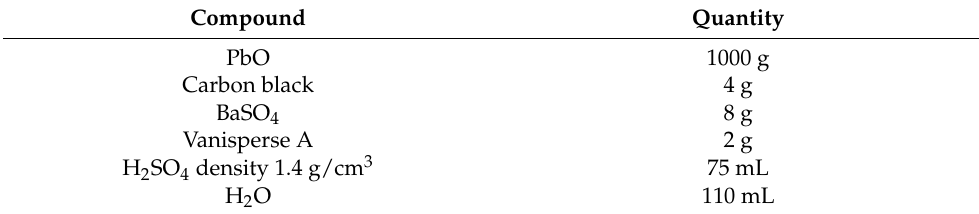
Table 1. Negative paste